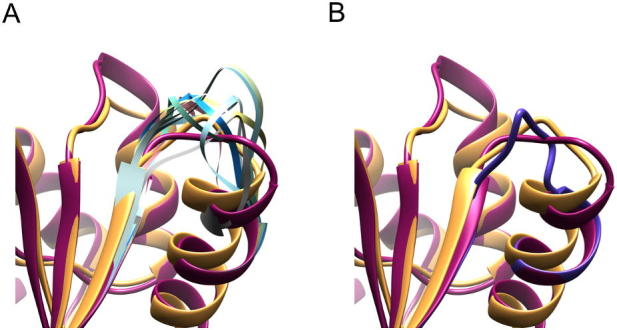
Refinement of loop 185–193 of E. coli adenylate kinase homology model in a 2.5 Å resolution map representing an inhibitor bound form (PDB: 1AKE). (A) Alternative conformations generated for segment 185–193 with MODELLER are shown as flat ribbons. The X-ray structure (1AKE) is colored in gold and the selected loop conformation for refinement in magenta. (B) Colors as in (A), the initial model from the SSE-based refinement is in purple.